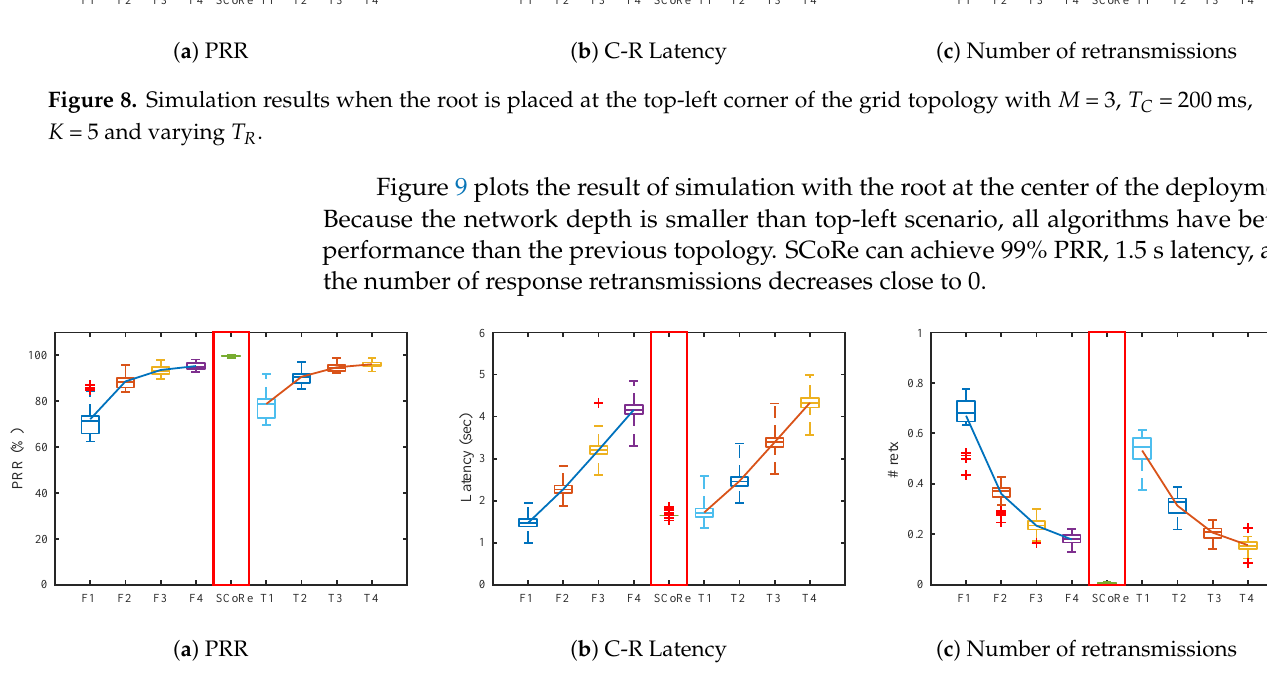
Figure 9. Simulation results when the root is placed in the middle of the grid topology with M = 3, T C = 200 ms, K = 5, and varying T R .